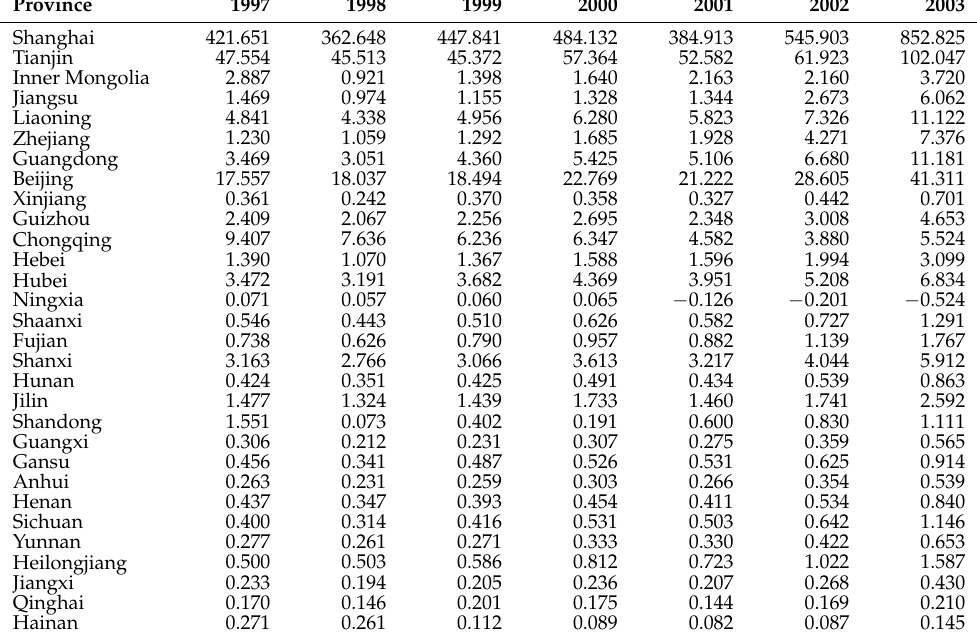
Table A2. The intra-provincial carbon inequality estimation results of original carbon emission data for 30 provinces in China from 1997 to